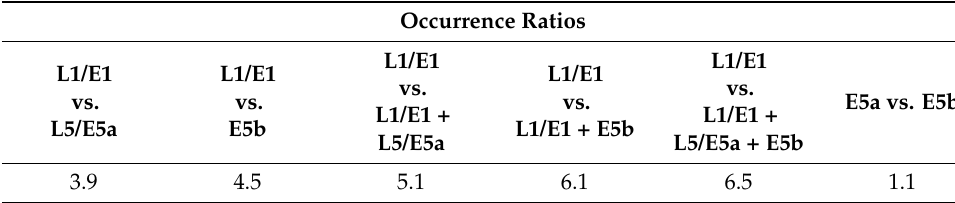
Table 4. Observed RFI occurrence ratios between L1/E1, E5a and E5b frequency bands alone and combined.